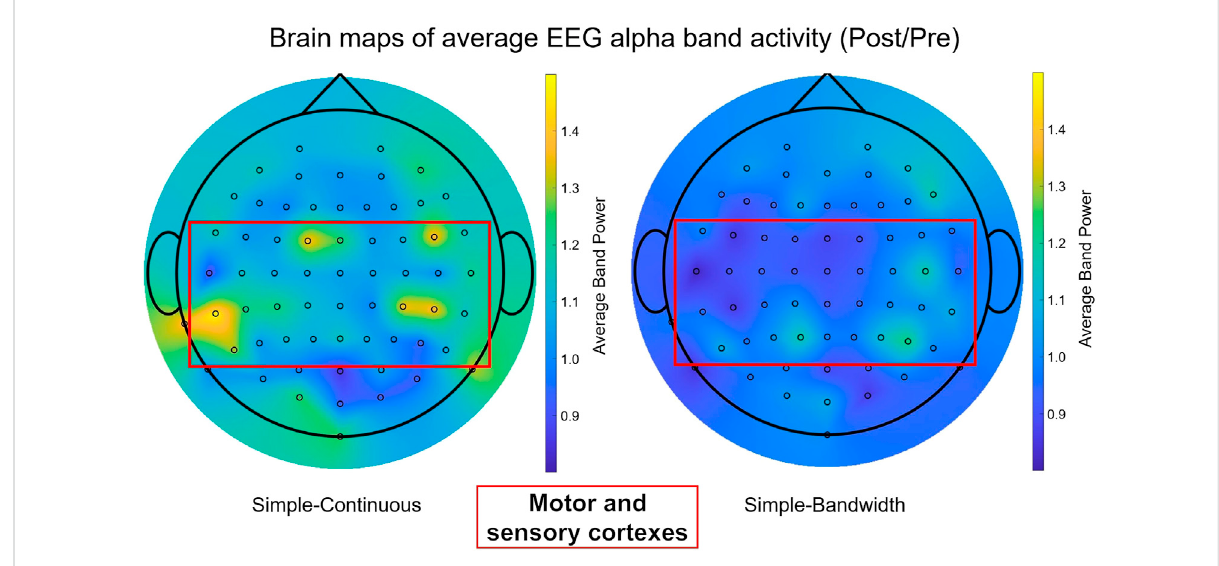
FIGURE 7 Brain map of EEG activity averaged for all participants. Electroencephalography (EEG) results to indicate changes in average alpha band activity during post-training from pre-training for simple-continuous (LEFT) and simple-bandwidth